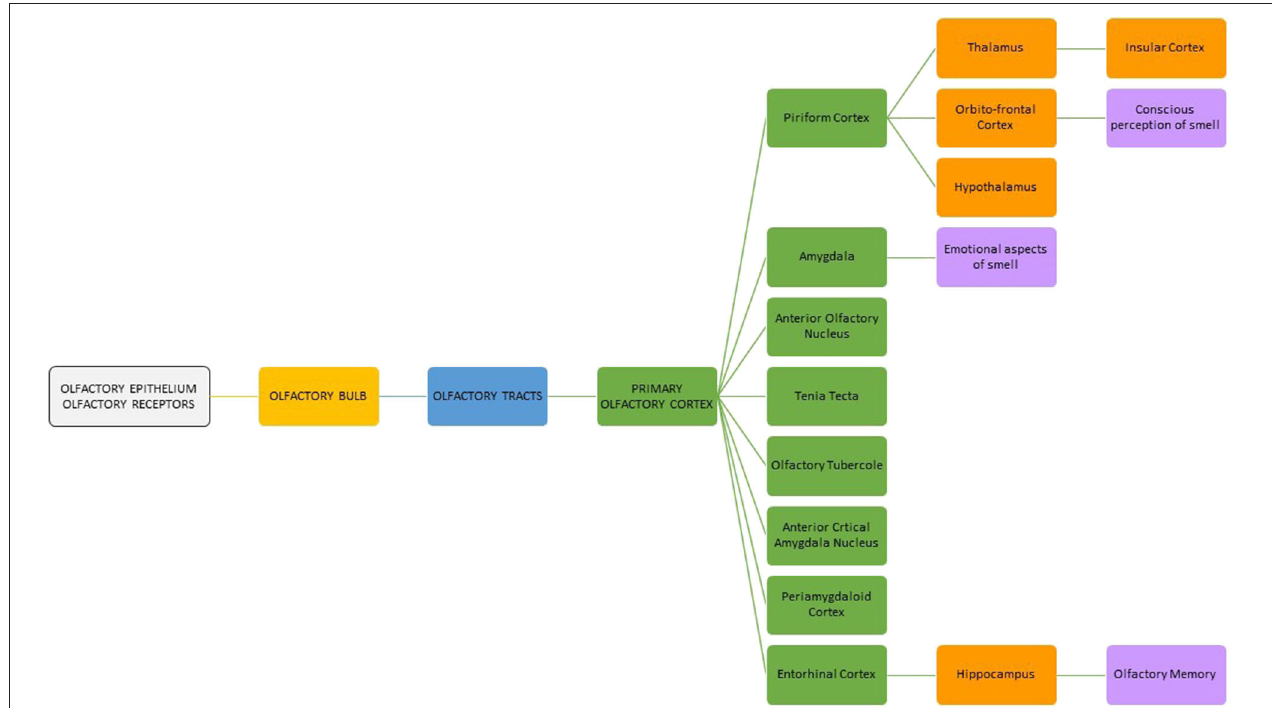
FIGURE 3 | Flowchart of olfactory